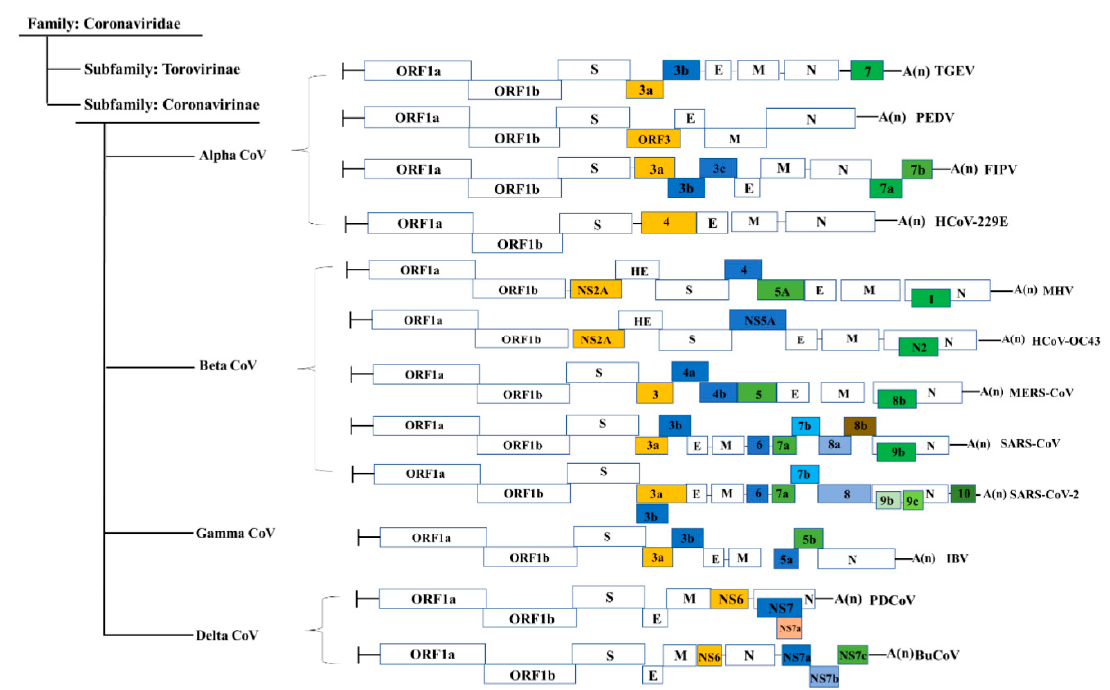
Figure 1. Genome organization of accessory genes from several representative coronaviruses. SARS-CoVs, severe acute respiratory syndrome coronaviruses; MERS-CoV, Middle Eastern respiratory syndrome coronavirus; HCoV-229E, human coronavirus 229E; HCoV-OC43, human coronavirus OC43; PEDV, porcine epidemic diarrhea virus; TGEV, transmissible gastroenteritis virus; MHV, mouse hepatitis virus; FIPV, feline infectious peritonitis virus; IBV, infectious bronchitis virus; BuCoV, bulbul coronavirus; PDCoV, porcine deltacoronavirus. Various accessory genes are shown as different colored boxes. ORFs 1a and 1b comprise the coronaviruses replicase genes. S, E, M, and N represent viral structural proteins. The figure is not drawn to scale.